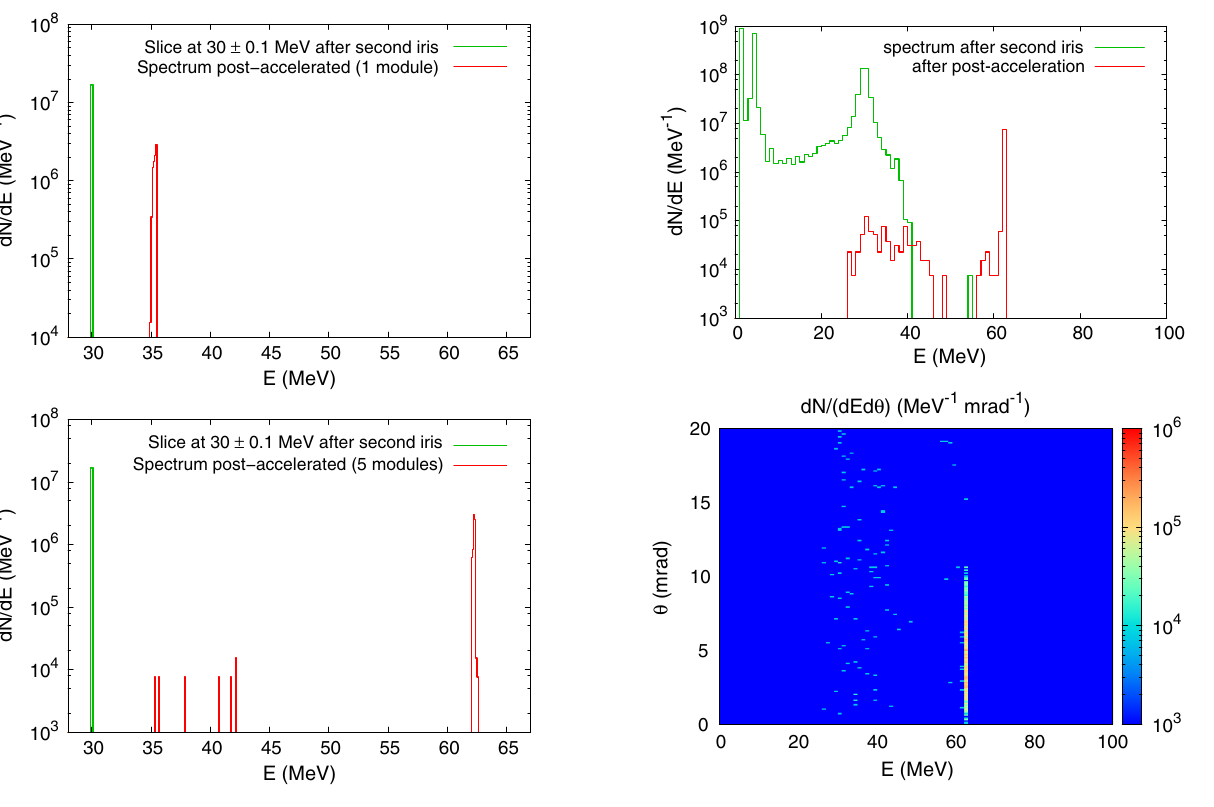
and p tot , (cid:8) , (cid:1) E=E , N refer to the x y p ð slice Þ